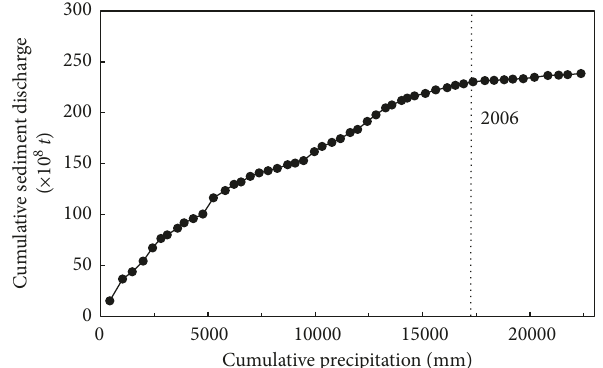
Figure 6: The double mass curve between rainfall and sediment discharge in the